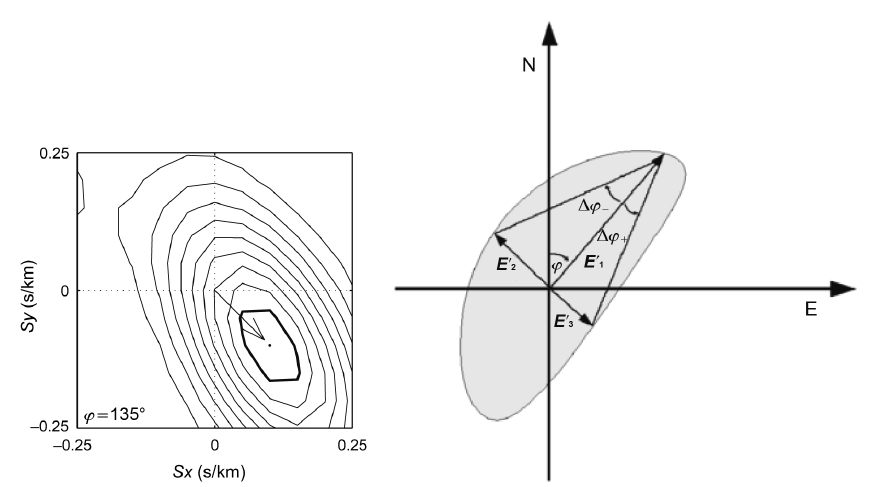
Fig. 5. Sketch of the procedures used for retrieving uncertainties in the estimates of the propagation ( left ) and polarization ( right ) parameters. On the left, a sample slowness spectrum is displayed, with evidenced the con- tour line encompassing that region for which the power is greater than 90% of the main peak’s power. This re- gion is used to define errors in azimuth and ray parameter estimates. On the right plot, the shaded area marks the projection onto the horizontal plane of the polarization ellipsoid. E l are the horizontal projections of the three eigenvectors; ϕ is the estimated polarization azimuths, whose uncertainties are defined through the angles ∆ϕ